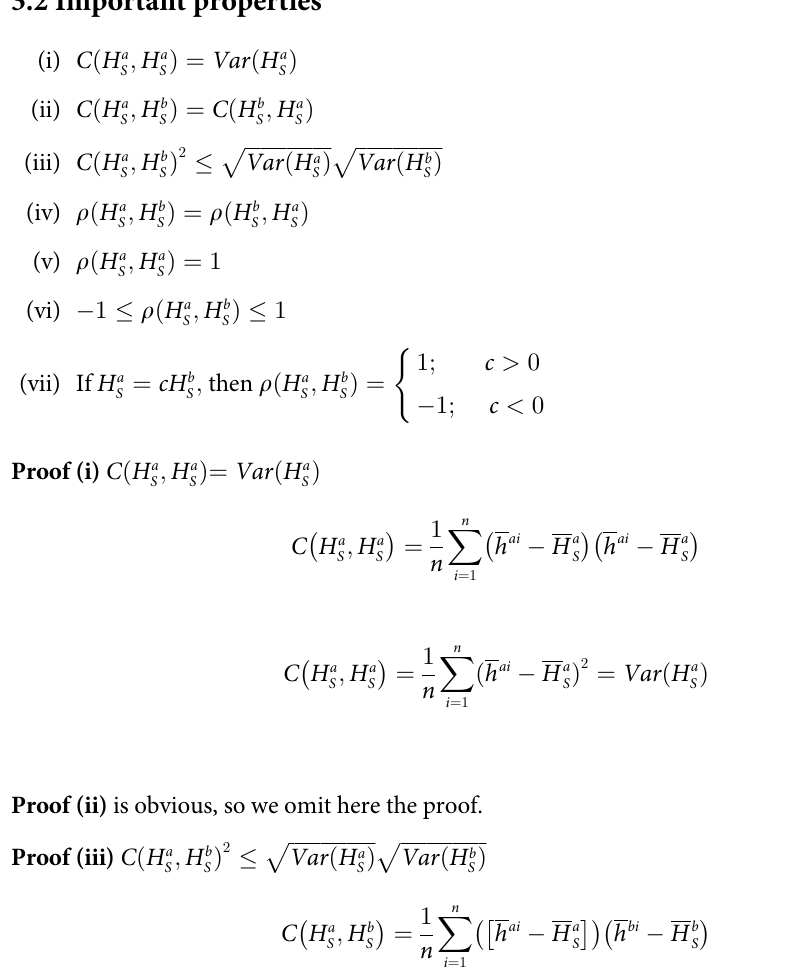
ffiffiffiffiffiffiffiffiffiffiffiffiffiffiffiffiffi p ffiffiffiffiffiffiffiffiffiffiffiffiffiffiffiffiffi Var ð H a